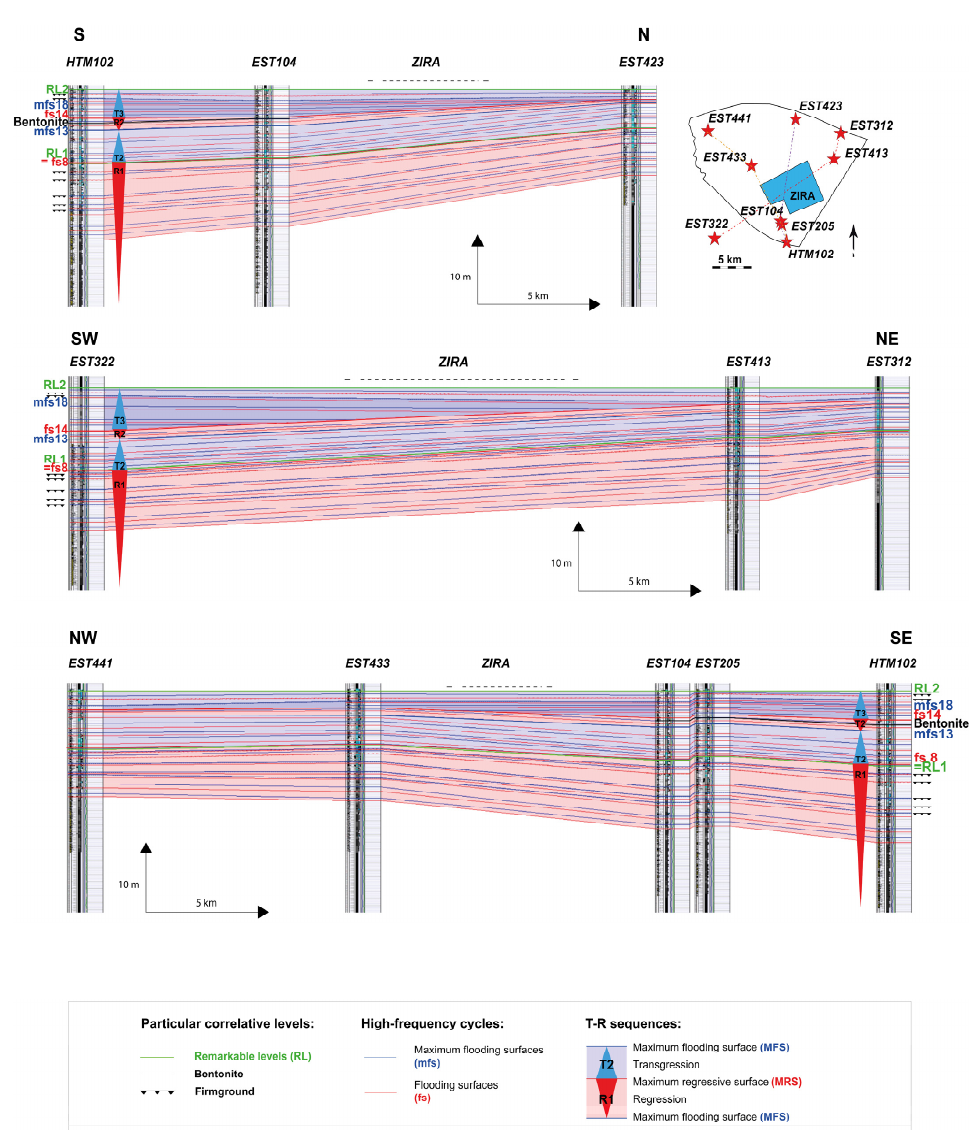
Figure 8. Correlation of the nine wells investigated around the ZIRA based on the main remarkable surfaces. Wells have been horizontalised on surface RS2.